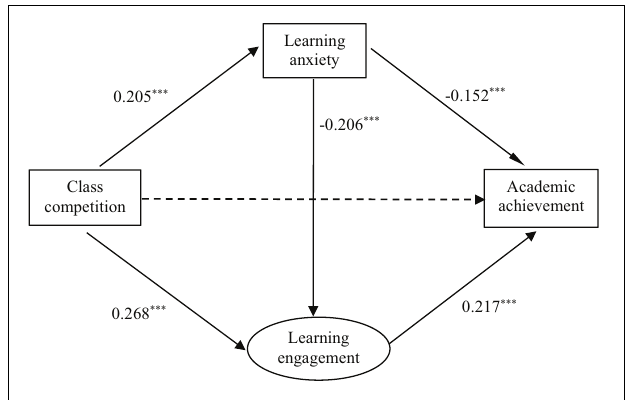
FIGURE 2 | Mediation effect model of class competition on academic achievement. *** p <